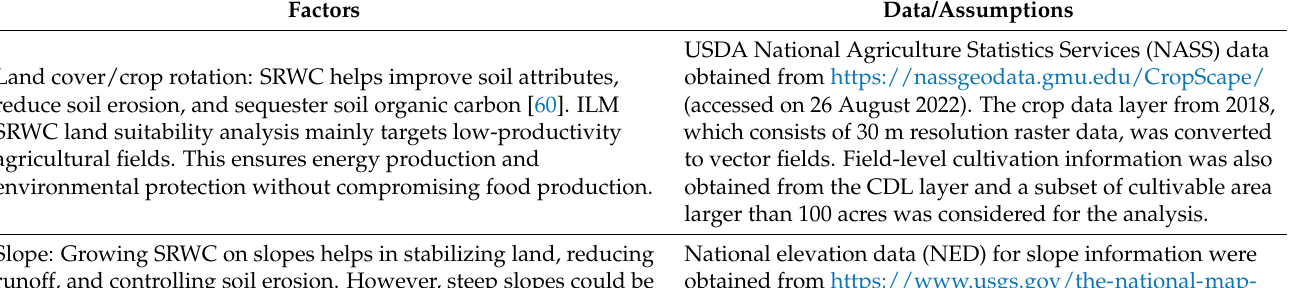
Table 1. Ecological/environmental factors considered for SRWC. Factors